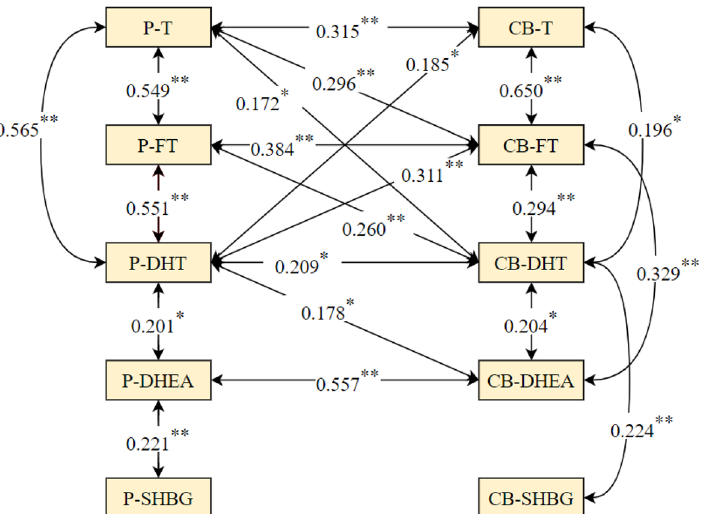
Figure 3. Relationships between prenatal androgens and cord blood androgens in female neonates. Notes: P-T prenatal testosterone, P-FT prenatal free testosterone, P-DHT prenatal dihydrotestosterone, P-DHEA prenatal dehydroepiandrosterone, P-SHBG prenatal sex hormone binding globulin, CB-T cord blood testosterone, CB-FT cord blood free testosterone, CB-DHT cord blood dihydrotestosterone, CB-DHEA cord blood